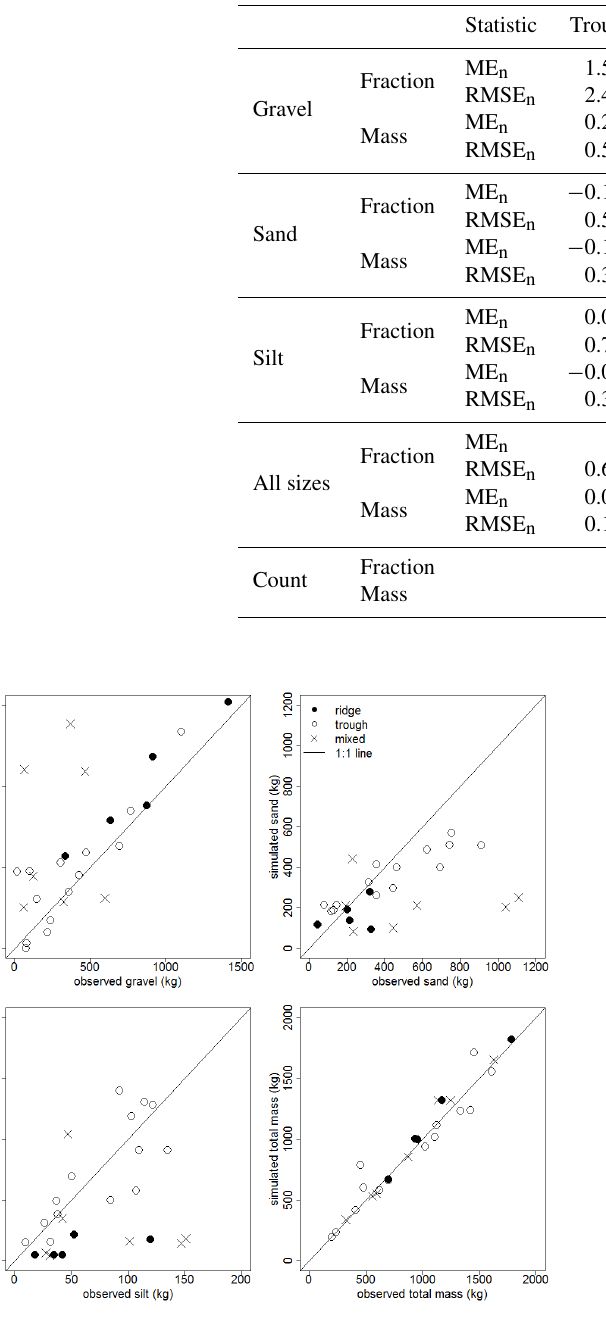
Table 4. Normalized RMSE and ME as validation statistics of the model results, ordered per geomorphic position. Mixed positions are locations where the model follows a different geomorphological setting than was observed in the field. This is due to loss of details with aggregation of the ridge–trough map to the cell size of the input DEM.